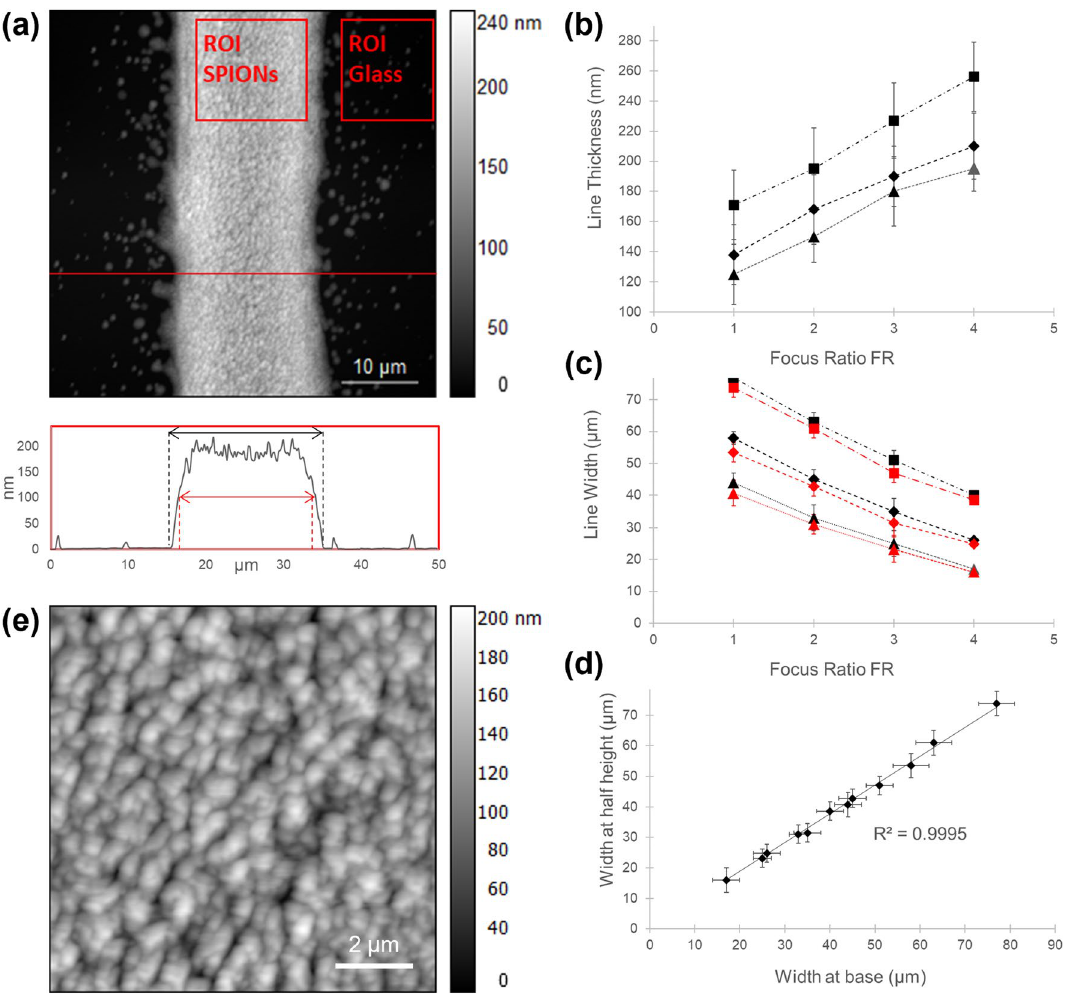
Figure 4. AFM analysis of SPIONs lines printed on glass slides. ( a ) Example of an AFM scan across a SPIONs printed line (carrier gas flow 10 SCCM, sheath gas flow 40 SCCM, FR = 4) and its cross-sectional profile along the horizontal red line. The line average thickness was evaluated as the difference between the average height of an ROI selected on the line surface (ROI SPIONs) and the average height of the ROI on the glass slide (ROI Glass). The width at base (black) and the width at half height (red) are also shown. ( b ) Line thickness plotted against focus ratio for different carrier gas flow rate: (Black Triangle) 10 SCCM, (Black diamond) 15 SCCM, (Black square) 20 SCCM. Error bars indicate the standard deviation of line height in AFM scans (RMS roughness). ( c ) Width at base (black) and the width at half height (red) plotted against focus ratio for different carrier gas flow rate: (Black Triangle)10 SCCM, (Black diamond)15 SCCM, (Black square) 20 SCCM. ( d ) Line width at half height versus line width at base. ( e ) 10 μm × 10 μm surface scan (carrier gas flow 10 SCCM, sheath gas flow 40 SCCM, FR =